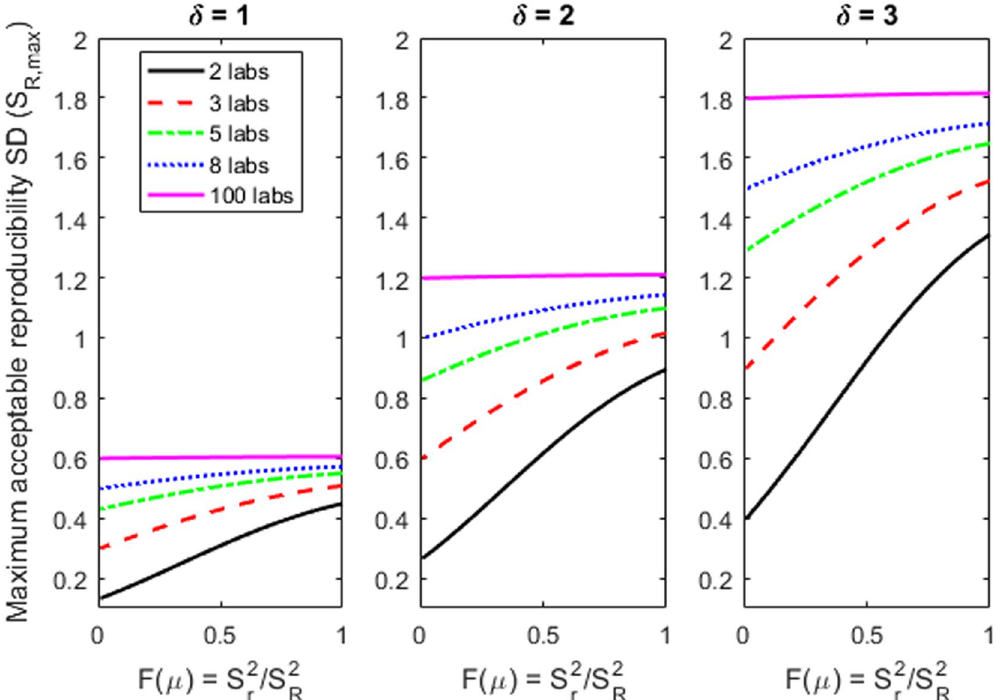
Figure 5. Assessing reproducibility of ANY antimicrobial test method according to a stakeholder’s specifications. For a range of stakeholder specifications ( δ = 1, 2 and 3; γ = 90% and F ( µ ) = S r2 /S R2 ), the maximum acceptable reproducibility SD of a method is determined, S R,max (via equation (1)). There is 1 other input: the number of labs in the multi-laboratory study of a